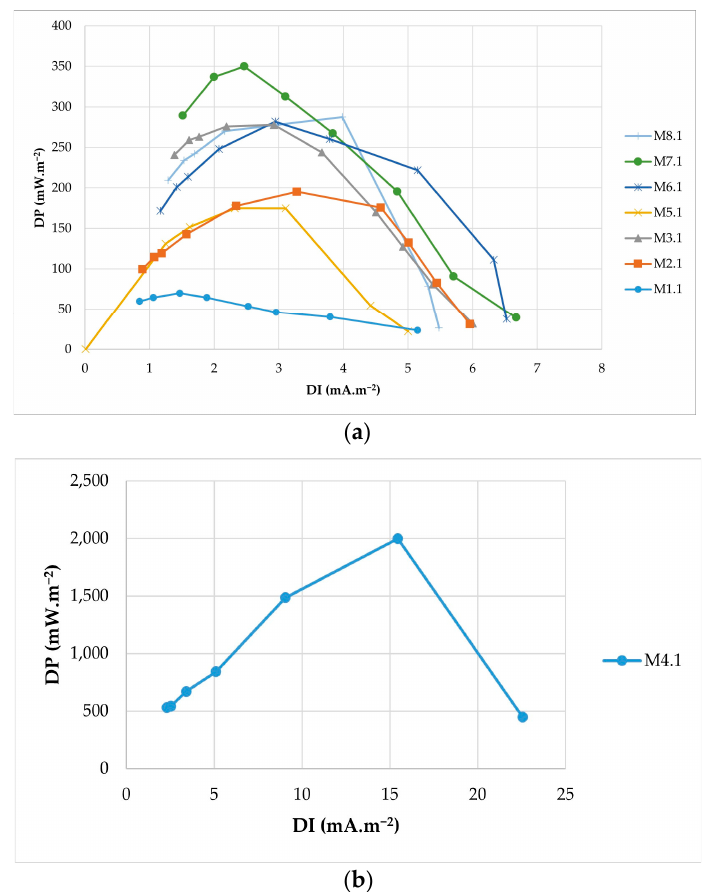
Figure 7. Polarization curves of each MFC at the end of closed-circuit operation: ( a ) experiments M1.1, M2.1, M3.1, M5.1, M6.1, M7.1, and M8.1; ( b ) experiment